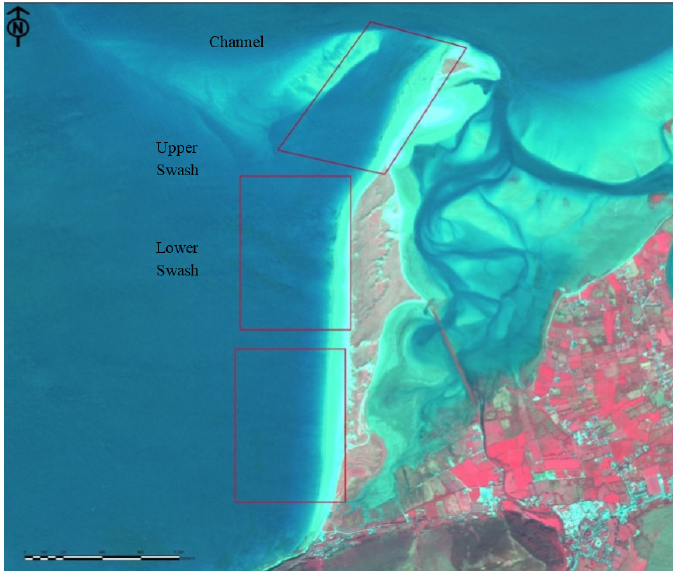
Figure 8. Volume comparison locations. Table 4. Volume comparison of morphodynamic simulations.